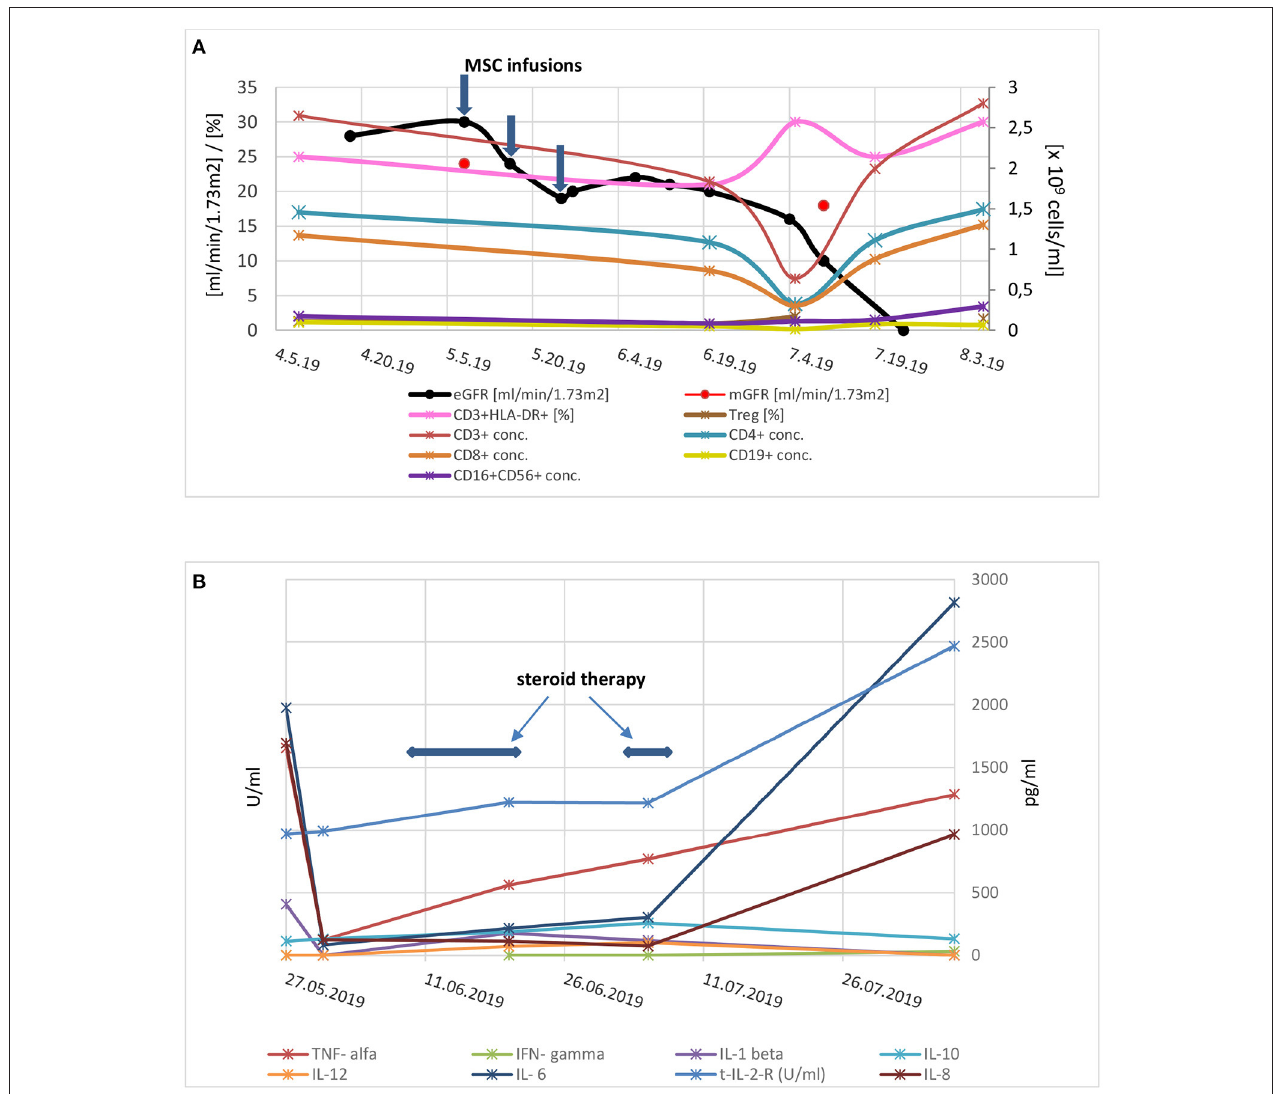
FIGURE 2 | (A) Kidney graft function and serum concentrations of lymphocyte populations before and after application of mesenchymal stem cells. Three consecutive applications of mesenchymal stem cells are marked with arrows. eGFR, estimated glomerular filtration rate; mGFR, measured glomerular filtration rate (by Cr-EDTA); conc, concentration; Treg, regulatory T cells. (B) Cytokine concentrations after mesenchymal stem cells application (in U/mL for soluble interleukin 2 receptor and in pg/mL for other cytokines). Time frame of corticosteroid treatment is marked with arrows; Legend: TNF, tumor necrosis factor; IL, interleukin; s-IL-2-R, soluble interleukin 2 receptor; IFN,